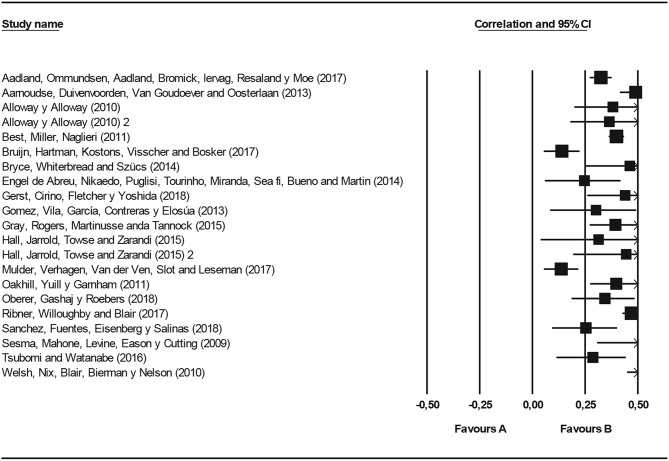
Forest plot effect size (Pearson's r). Executive functions—academic performance.